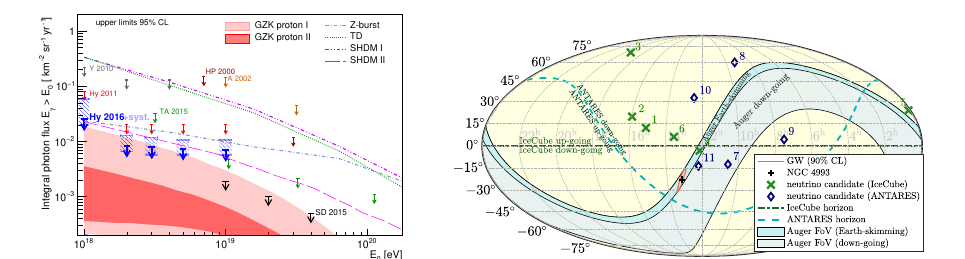
Figure 3. Left : Upper limits on the di ff use photon compared to limits from other experiments and model predictions; see [11] for references. Right: Localizations and sensitive sky areas at the time of the GW event in equatorial coordinates: GW 90% credible-level localization (red contour); see [13] for details and references. Auger’s fields of view for Earth-skimming and down-going neutrinos are indicated in dark and lighter blue